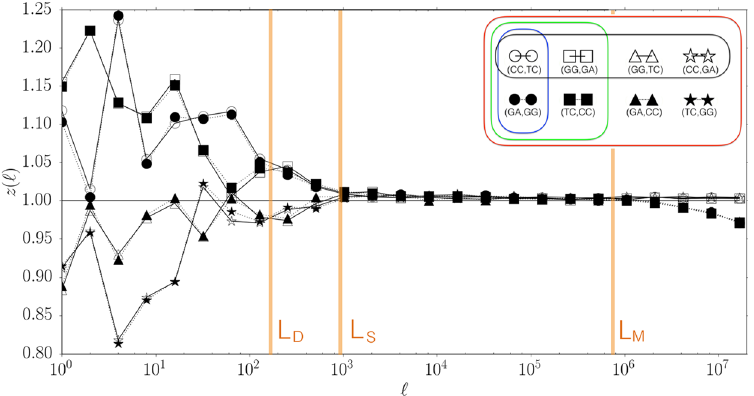
Figure 1. Symmetrically related cross-correlations in Homo Sapiens - Chromosome 1. The normalized cross- correlations z ( )  as a function of the scale  , together with that of its symmetrical related companions. CC TC [ , ] Symmetries are significant also at scales where non trivial correlations are present z ≠ 1.